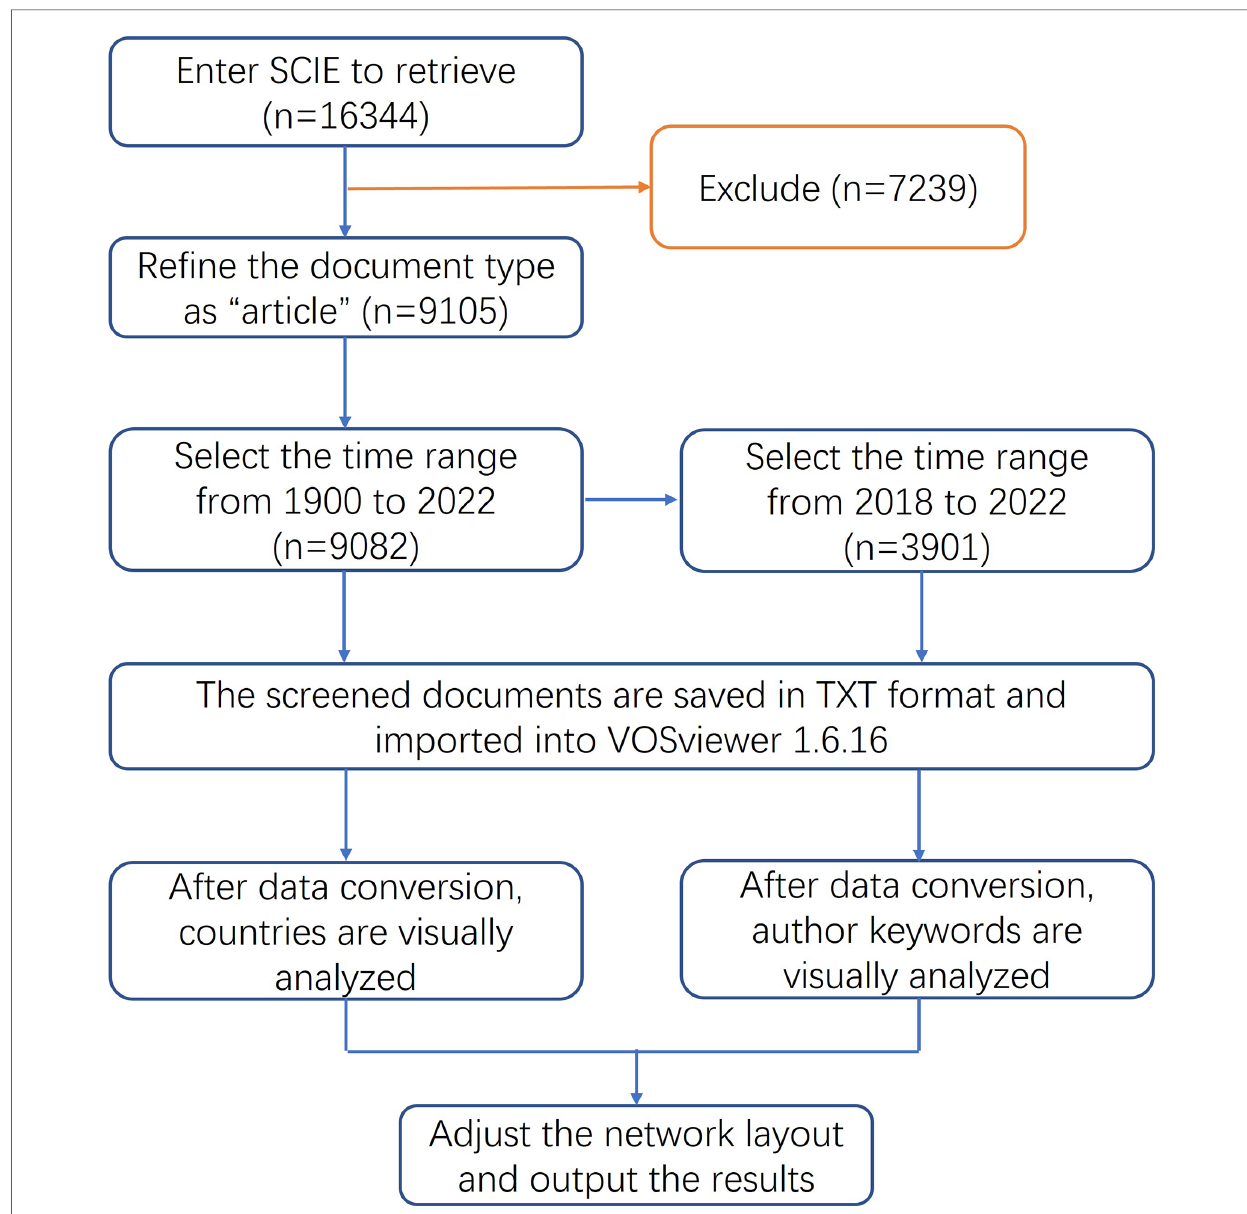
FIGURE 1 Visual analysis fl ow chart of ECMO research fi